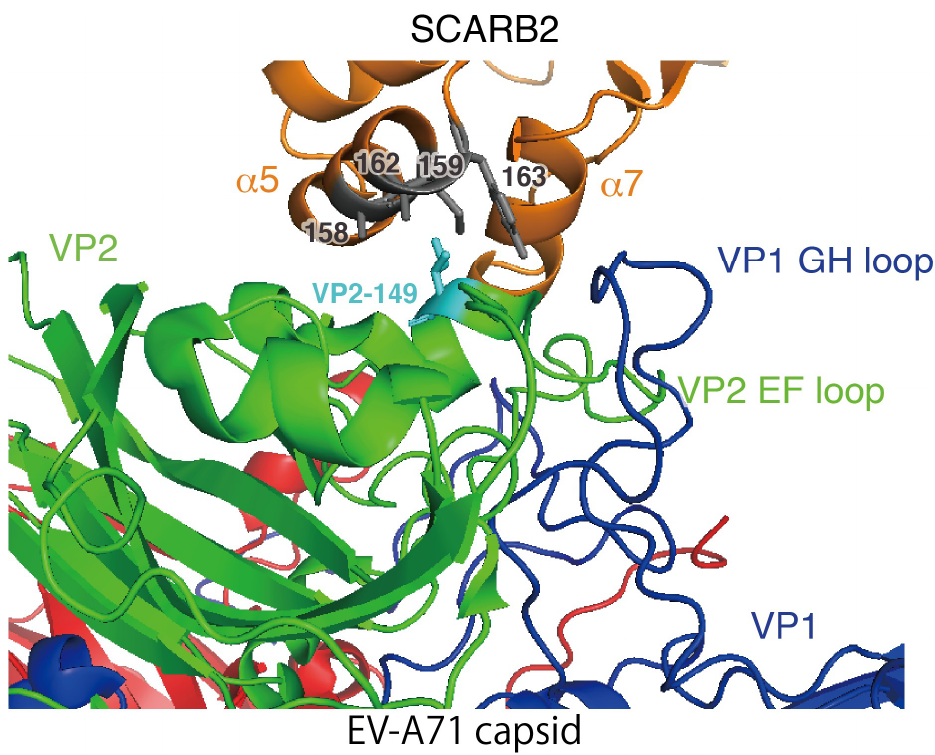
Figure 2. The binding site of VP2-149 and hSCARB2. The 3D structure of the EV-A71 capsid protomer (VP1, VP2, and VP3 in blue, green, and red, respectively) and the ectodomain of hSCARB2 (orange) are shown in cartoon representation. VP2-149 is shown as a cyan stick, and hSCARB2 residues 158A, 159M, 162A, and 163Y are shown as gray sticks. This figure was produced using Protein Data Base 6I2K.